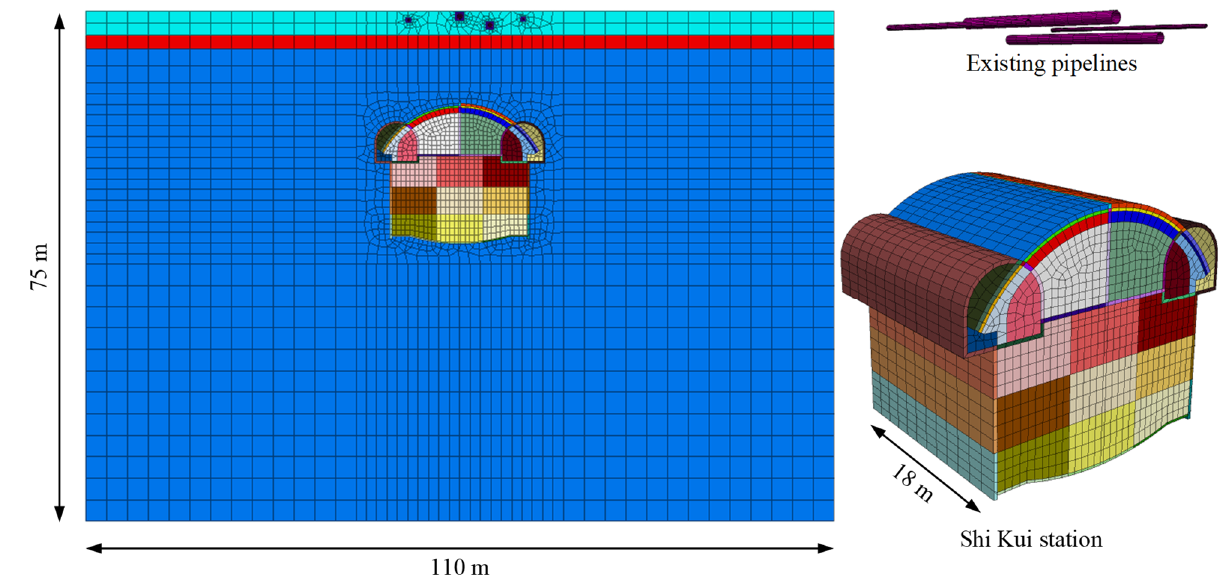
Figure 7. Numerical model of Shi Kui Subway Station.